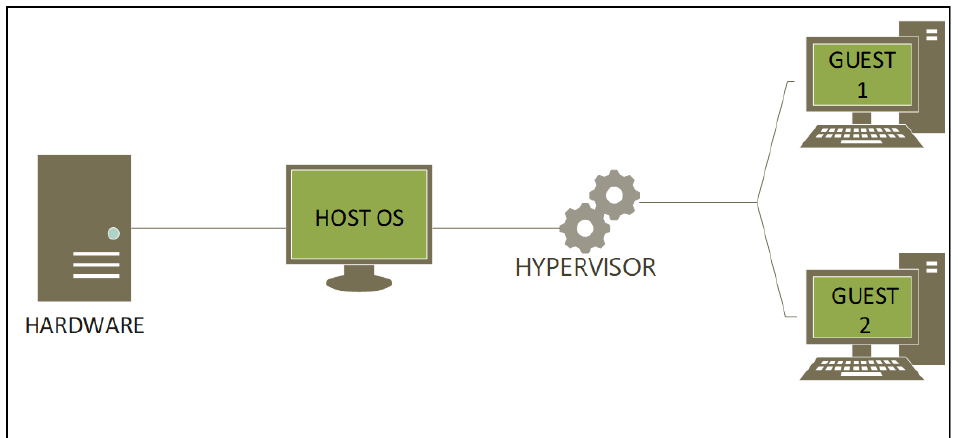
Figure 2. Type 2 hypervisor.